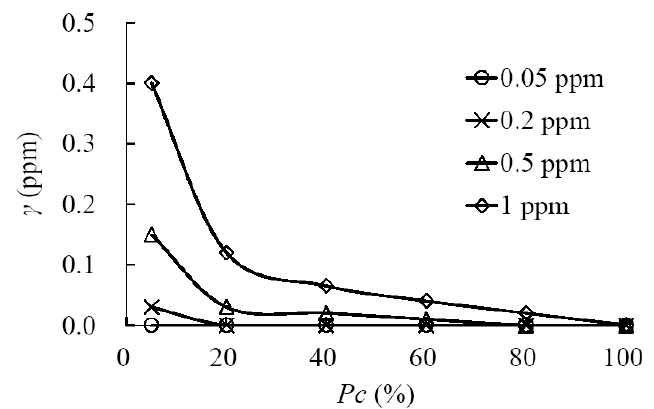
Figure 14. XCH 4 underestimation ( γ) with the subpixel percent coverage ( Pc ) of the GOSAT pixel covered by a CH 4 plume anomalies from 0.05 to 1 ppm, remainder background CH 4 . Data key on figure.